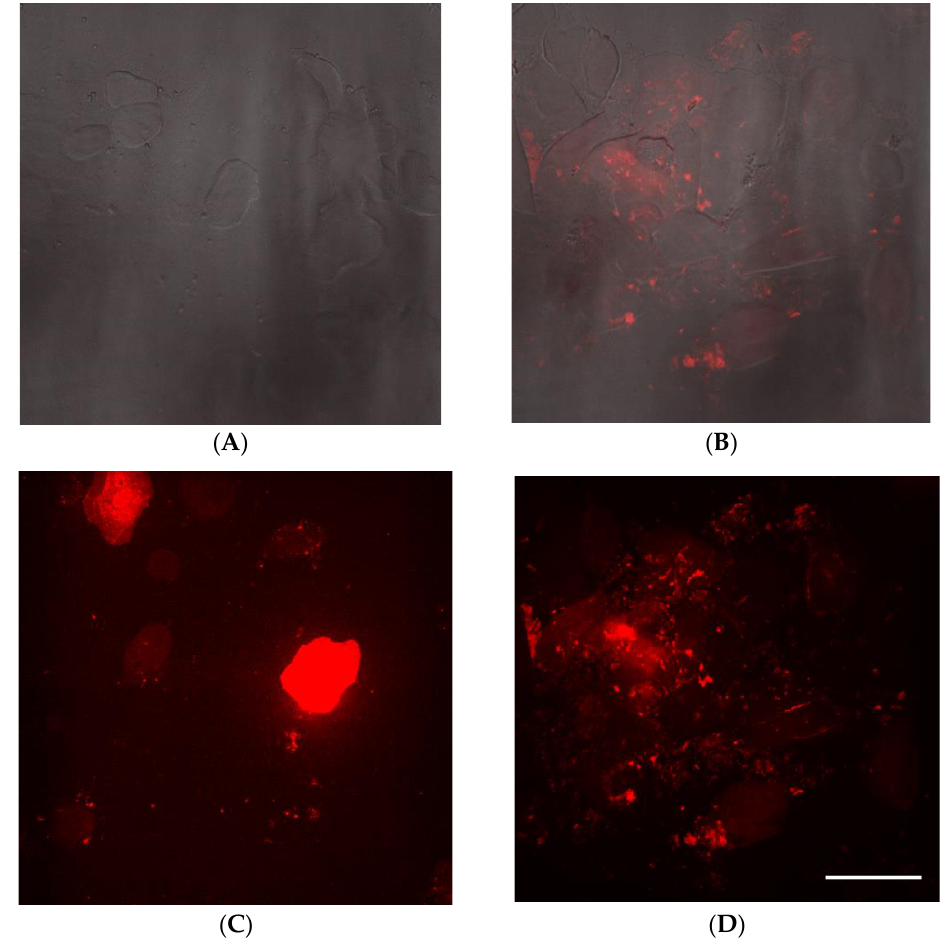
Figure 3. Fluorescence microscopy of vaginal smears. ( A , B ) are overlays of Differential interference contrast (DIC) and Fluorescent Light. ( A ), un-treated mice; ( B ), mice treated with LRPE-Nano-mupirocin; ( C , D ), smears of LRPE-Nano-mupirocin observed under fluorescent light. Scale bar = 50 µ